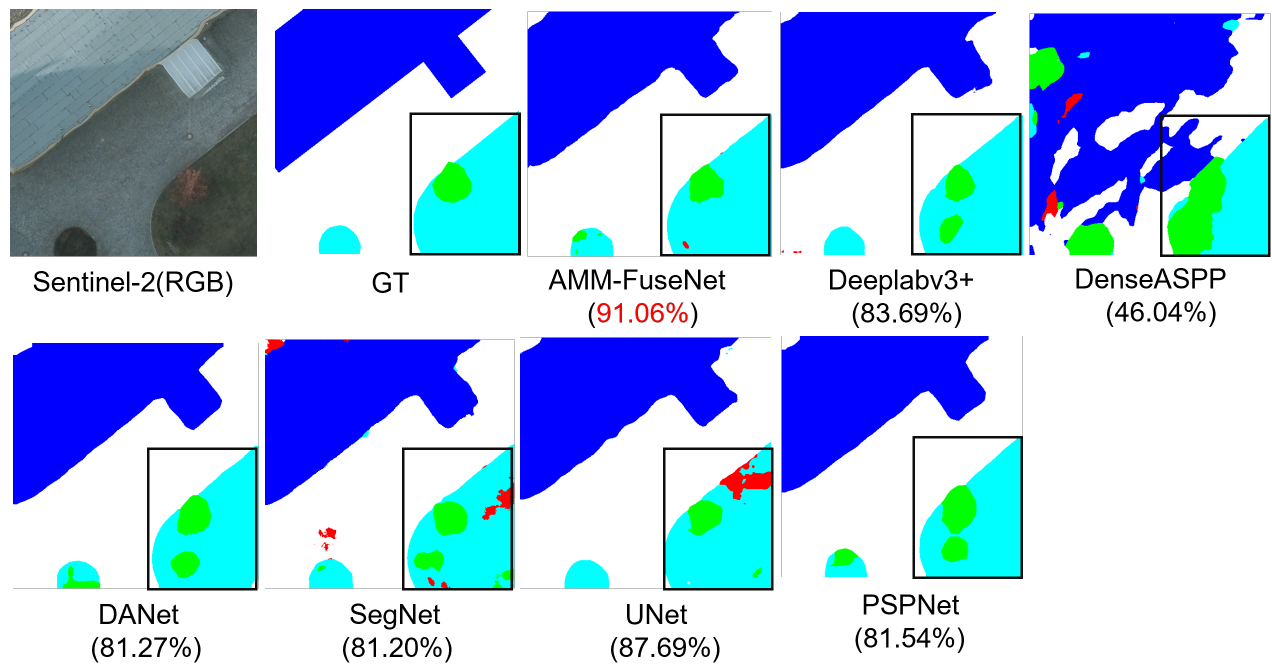
Figure 9. Results on the DFC2020 dataset. Values between parentheses refer to mIoU in percentages for the example image for each model, where the best model is shown in red.